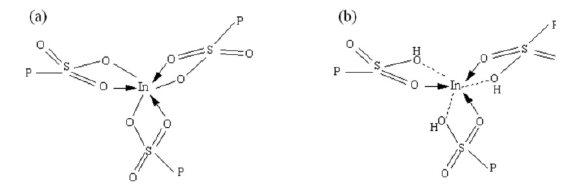
Figure 9. Proposed In(III) adsorption mechanism with Dowex 50w-x8 (a) complexation and ion exchange (b)